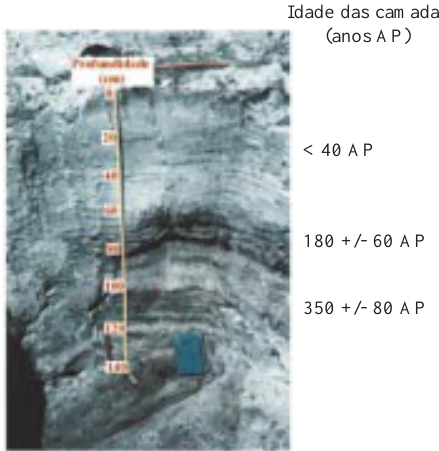
Figura 3. Aspectos morfológicos do Neossolo Flúvico Psamítico típico -